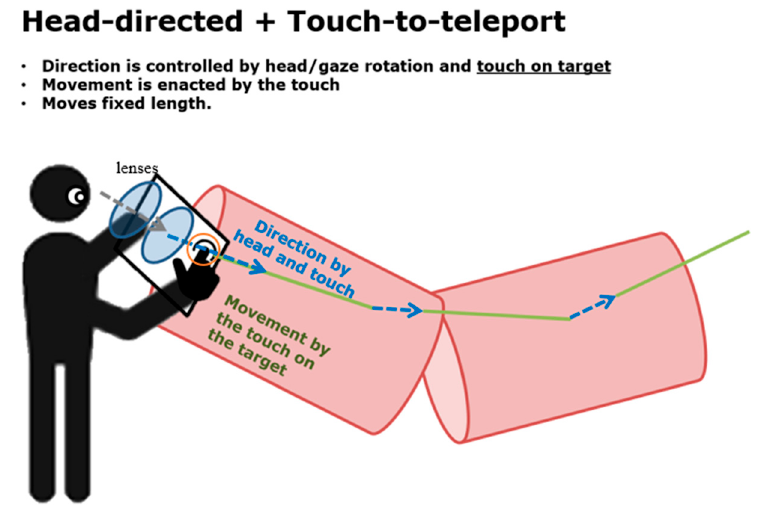
Figure 3. The head-directed, touch-to-go interface (HD + TG). The red cylinders represent the virtual tunnel segments through which the user needs to navigate in the experimental task. The gaze is estimated by the orientation of the hand-held smartphone and sets the movement direction. A single touch on the target on the screen (indicated with the red circle) enacts the virtual teleport to a new position toward the selected target by a predefined fixed distance.